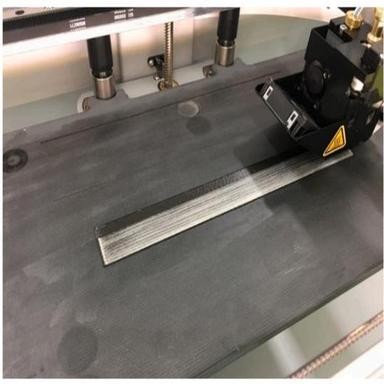
Overprinting carbon-fibre filament (black) onto a fibreglass substrate (white) using the Mark Two 3D printer. (For interpretation of the references to colour in this figure legend, the reader is referred to the web version of this article.)